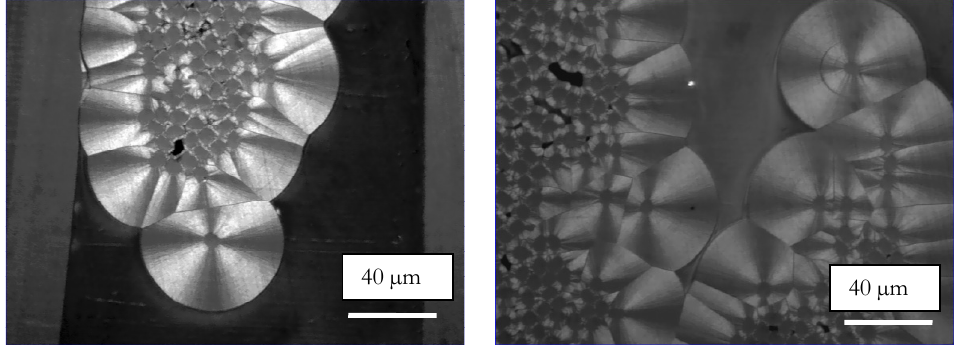
Figure 2: PLM micrographs of Py-C deposited around the carbon fibres at 1300 °C.